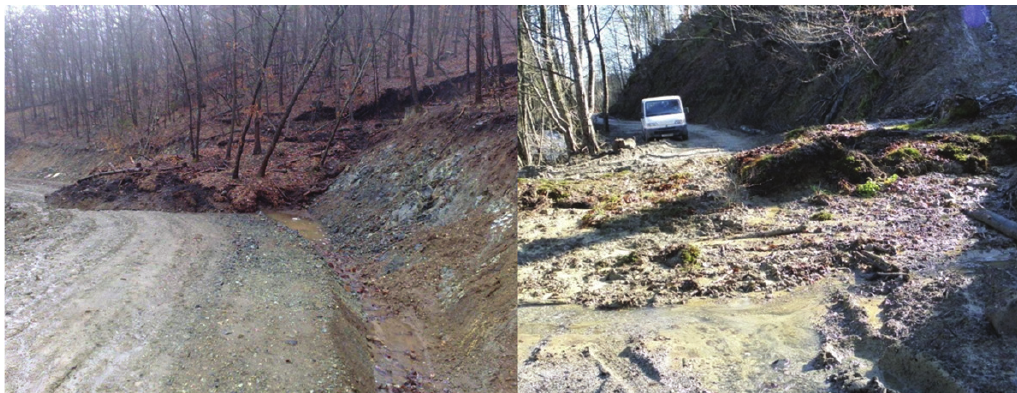
FIGURE 4. Left: Damages on forest road caused by landslide. Right: Damages on forest